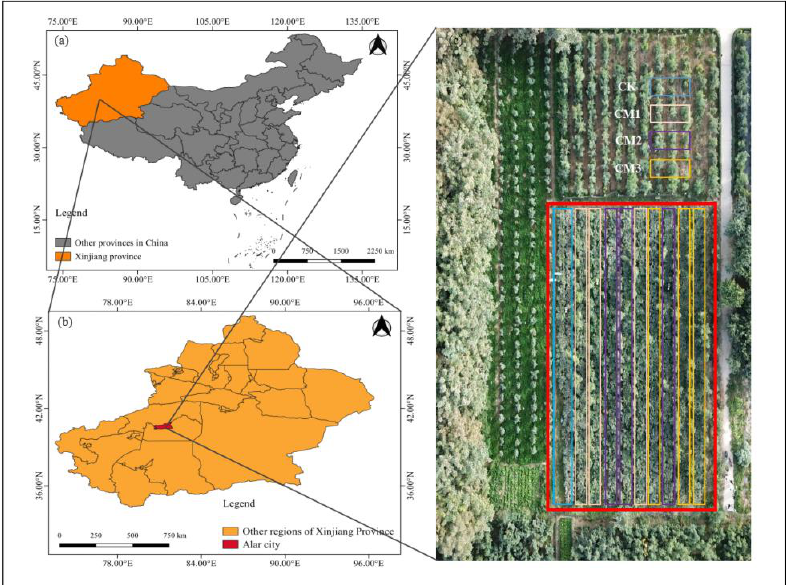
Figure 1. Study area map. ( a ) The location of Xinjiang province; ( b ) the location of the Alar city site; ( c ) the image of the experimental field (red box area) obtained on 16 September 2021 using a unmanned air vehicle.